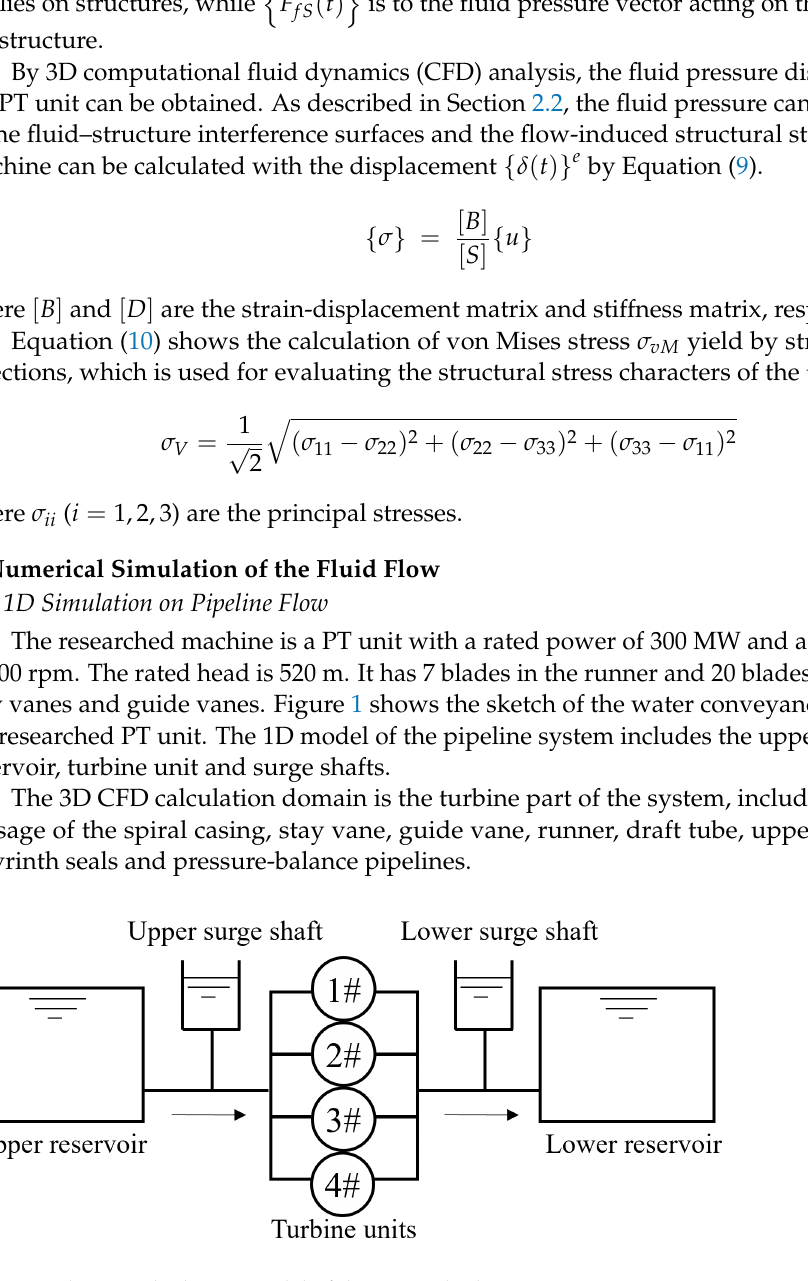
Figure 1. The 1D calculation model of the researched PT